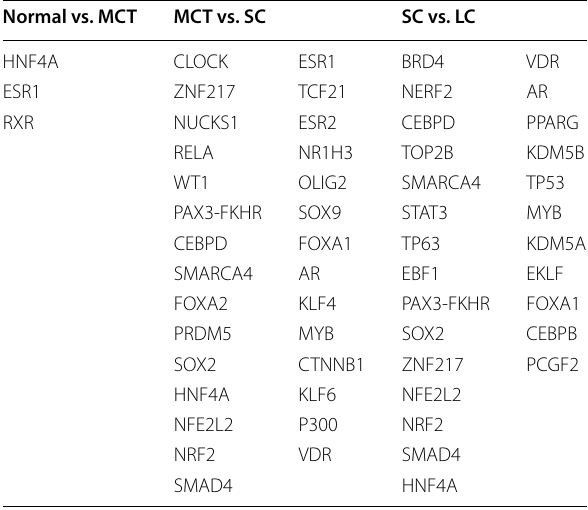
TFs were obtained with adjusted p-value < 0.05